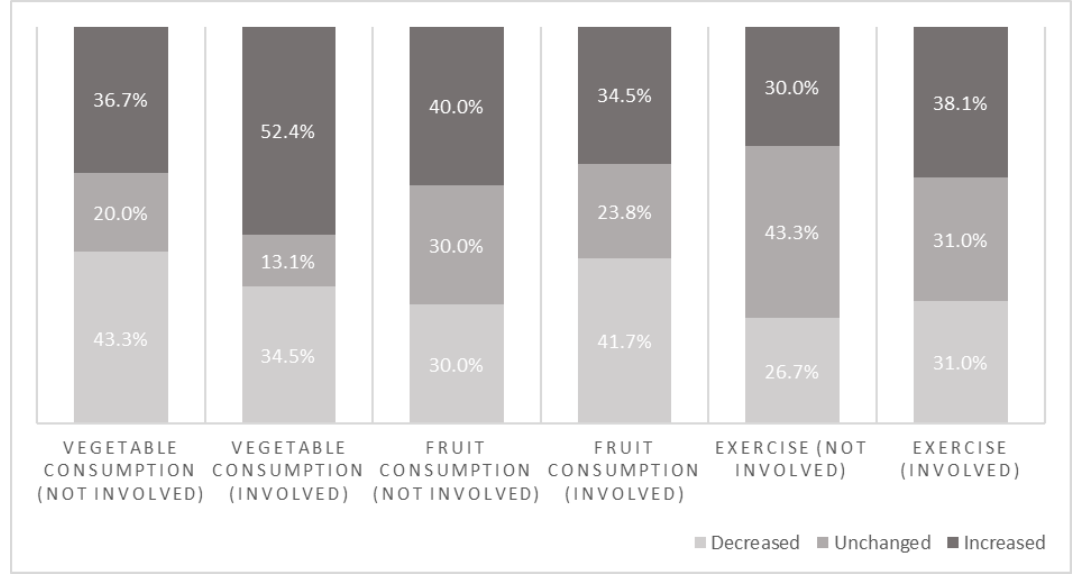
Figure 4. Percentages of categorical change in lifestyle behaviors between T0 and T1 within involvement-based subgroups.